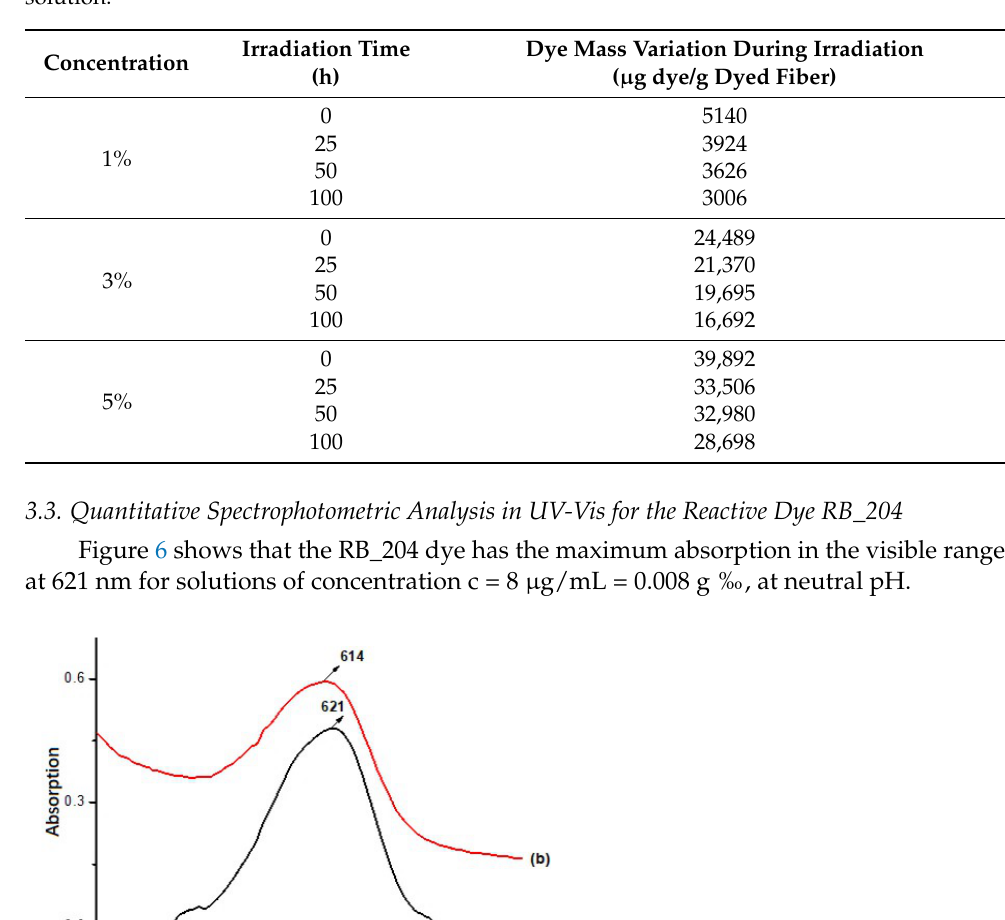
Table 4. The amount of dye existing on the fibers treated with 1%, 3%, and 5% dye concentration solution.